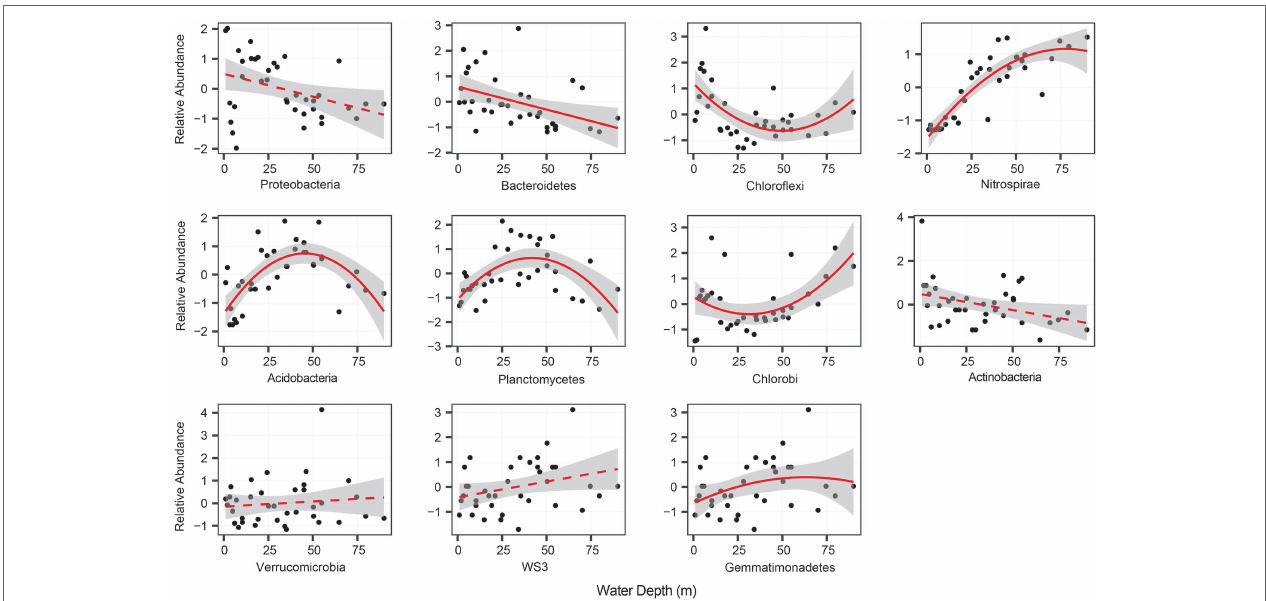
FIGURE 1 | The relative abundance of bacterial phyla along the water-depth gradient. The relationships between water depth and relative abundance were modeled with linear and quadratic models. The better model was selected based on the lower value of Akaike’s information criterion. For better visualization, species relative abundance was scaled as mean = 0 and SD = 1.